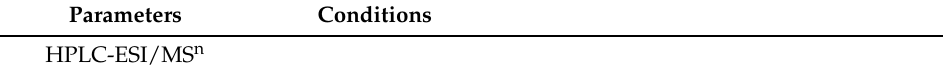
Table 5. Conditions to isolate and identify justicidin B by HPLC-ESI/MS n